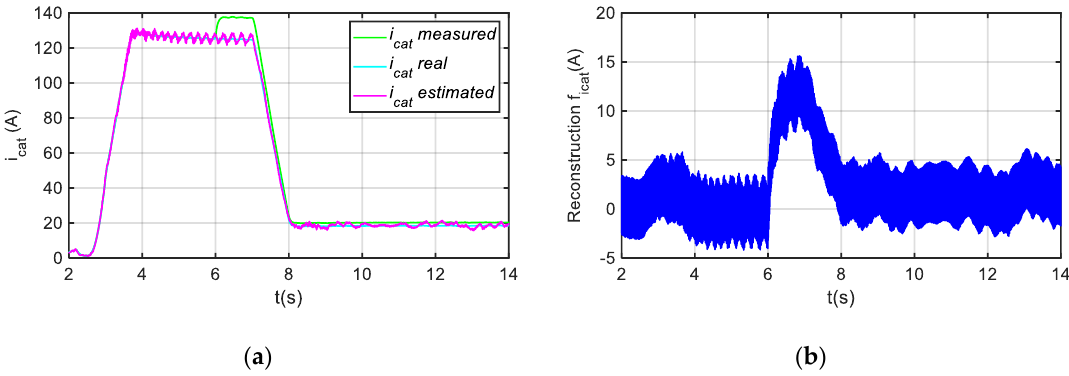
Figure 7. Injection of a gain fault of + 10% in catenary current sensor. ( a ) Measure, real and estimated catenary current. ( b ) Catenary current sensor fault reconstruction